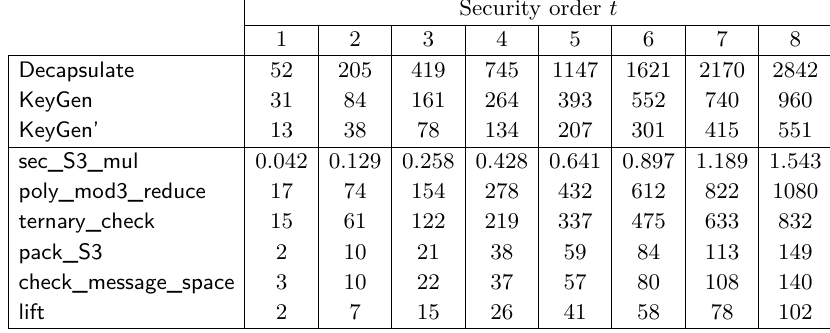
Table 9: Randomness usage for key generation, decapsulation and main gadgets, in thousands of calls to the RNG outputting 32 bits of randomness.